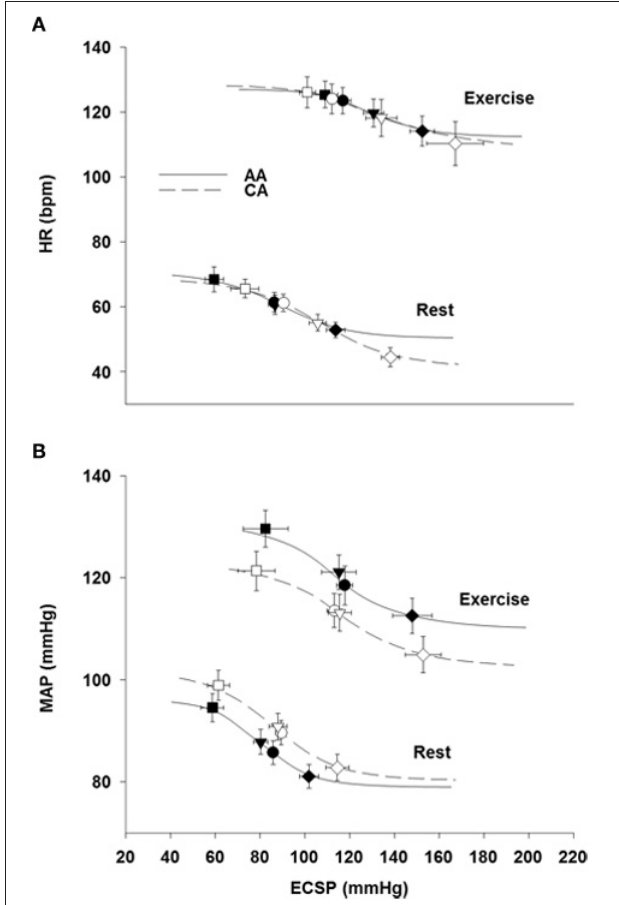
FIGURE 3 | Modeled carotid-cardiac (A) and carotid-vasomotor (B) baroreflex function curves at rest and during exercise in African Americans (AA, solid lines) and Caucasian Americans (CA, dashed lines). ECSP, estimated carotid sinus pressure. Filled symbols represent AA and open symbols represent CA. Circles represent operating points, inverted triangles represent centering points, squares represent carotid sinus pressure threshold, rotated squares represent carotid sinus pressure